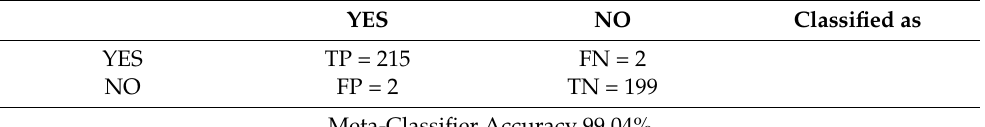
Table 4. Confusion matrix on test set.